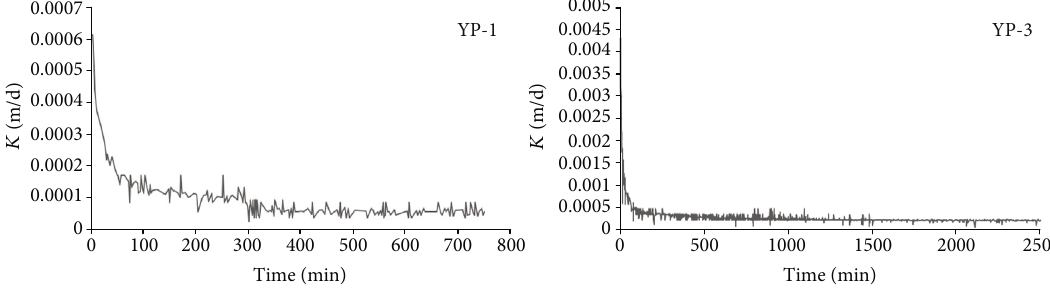
Figure 6: The hydraulic conductivity curve of YP-1 and